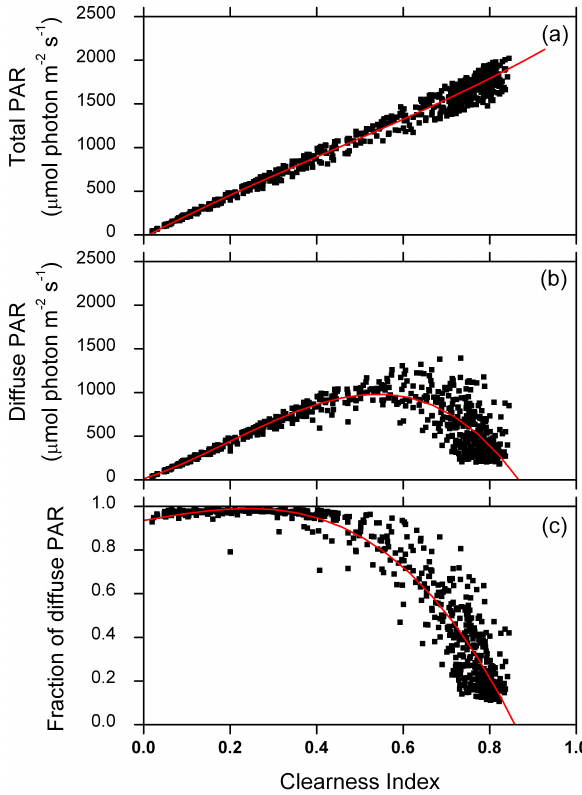
Fig. 4. Relationships between total PAR (a) , and diffuse PAR (b) , and the fraction of diffuse PAR (c) , and clearness index for 3rd poly- nomial fits ( n = 663, (a) r 2 = 0 . 98, (b) r 2 = 0 . 68, (c) r 2 = 0 . 92, p < 0 . 01),